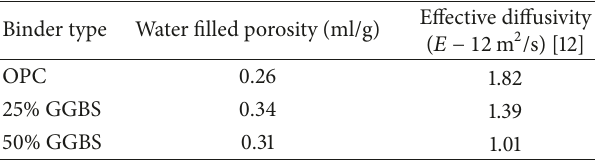
Table 1: Parameter values of pore structure. Binder type